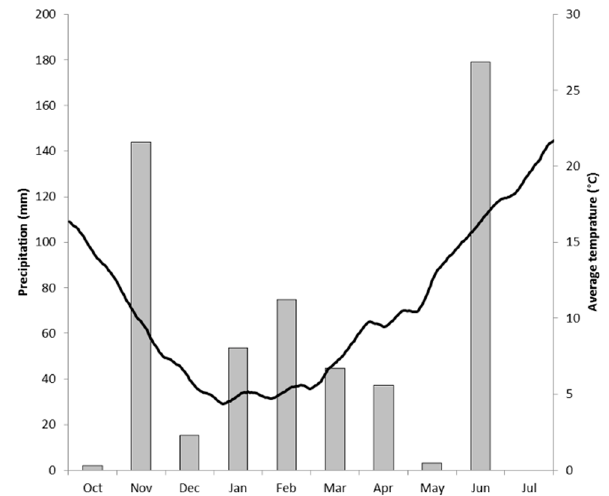
Figure 2. Plot of the weather data for the field site during the experimental period. From mid-October 2014 to mid-July 2015, monthly precipitations (mm) and ten-days’ average air temperature (°C) are displayed. Over the experimental period, the cumulated rainfall was 537.9 mm.